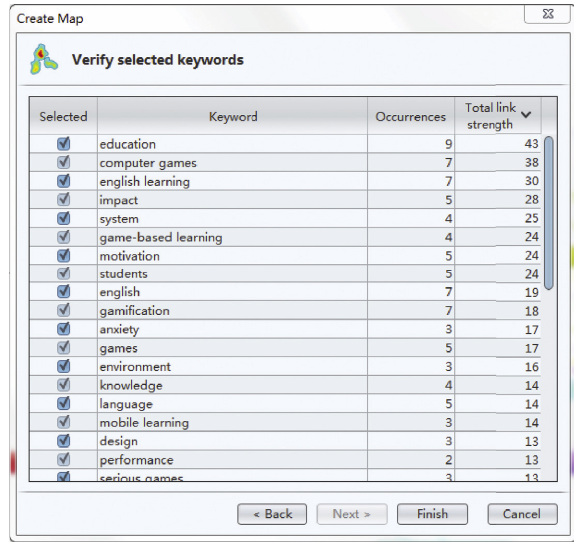
Figure 3: Keywords and total link